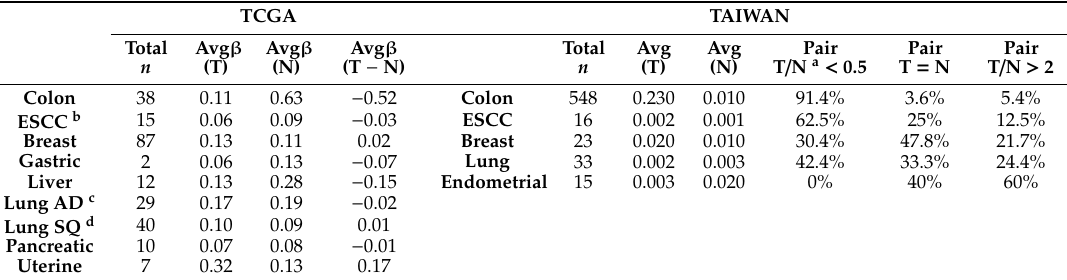
Figure 7. SMAD3 DNA methylation in di ff erent cancers. Di ff erentially methylated CpG heatmap of SMAD3 in paired liver cancer, rectal cancer, gastric cancer, esophageal cancer, and uterine cancer. Methylation levels (average β values) at di ff erentially methylated loci were identified by using an Illumina Human Methylation 450K array-based assay. Table 2. Methylation level of SMAD3 in di ff erent